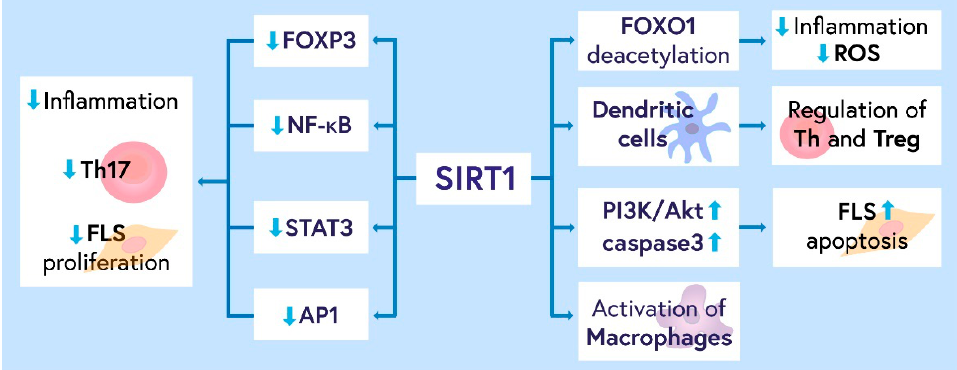
Figure 1. The role of SIRT1 in RA and other autoimmune diseases. SIRT1 could decrease inflammation by inhibiting transcriptional factors such as NF- κ B, STAT3, AP-1, FoxP3, FOXO1 deacetylation, and macrophage activity inhibition. By regulating dendritic cells, SIRT1 could control the response mediated by Th and Treg cells. The FLs proliferation and apoptosis are controlled by SIRT1 activity through PI3K/Akt, caspase 3, and NF- κ B pathways. Abbreviations: FLs, synoviocytes fibroblasts; AP1, activator protein 1; ROS, reactive oxygen species; Th, T helper cells; Treg, T regulatory cells; Th17, T helper 17 cells; FOX, forkhead box; STAT3, signal transducer and activator of transcription 3; NF- κ B, nuclear factor kappa B; PI3K/Akt, phosphatidylinositol 3-kinase (PI3K)/protein kinase B (AKT) signaling pathway; SIRT1, sirtuin 1.